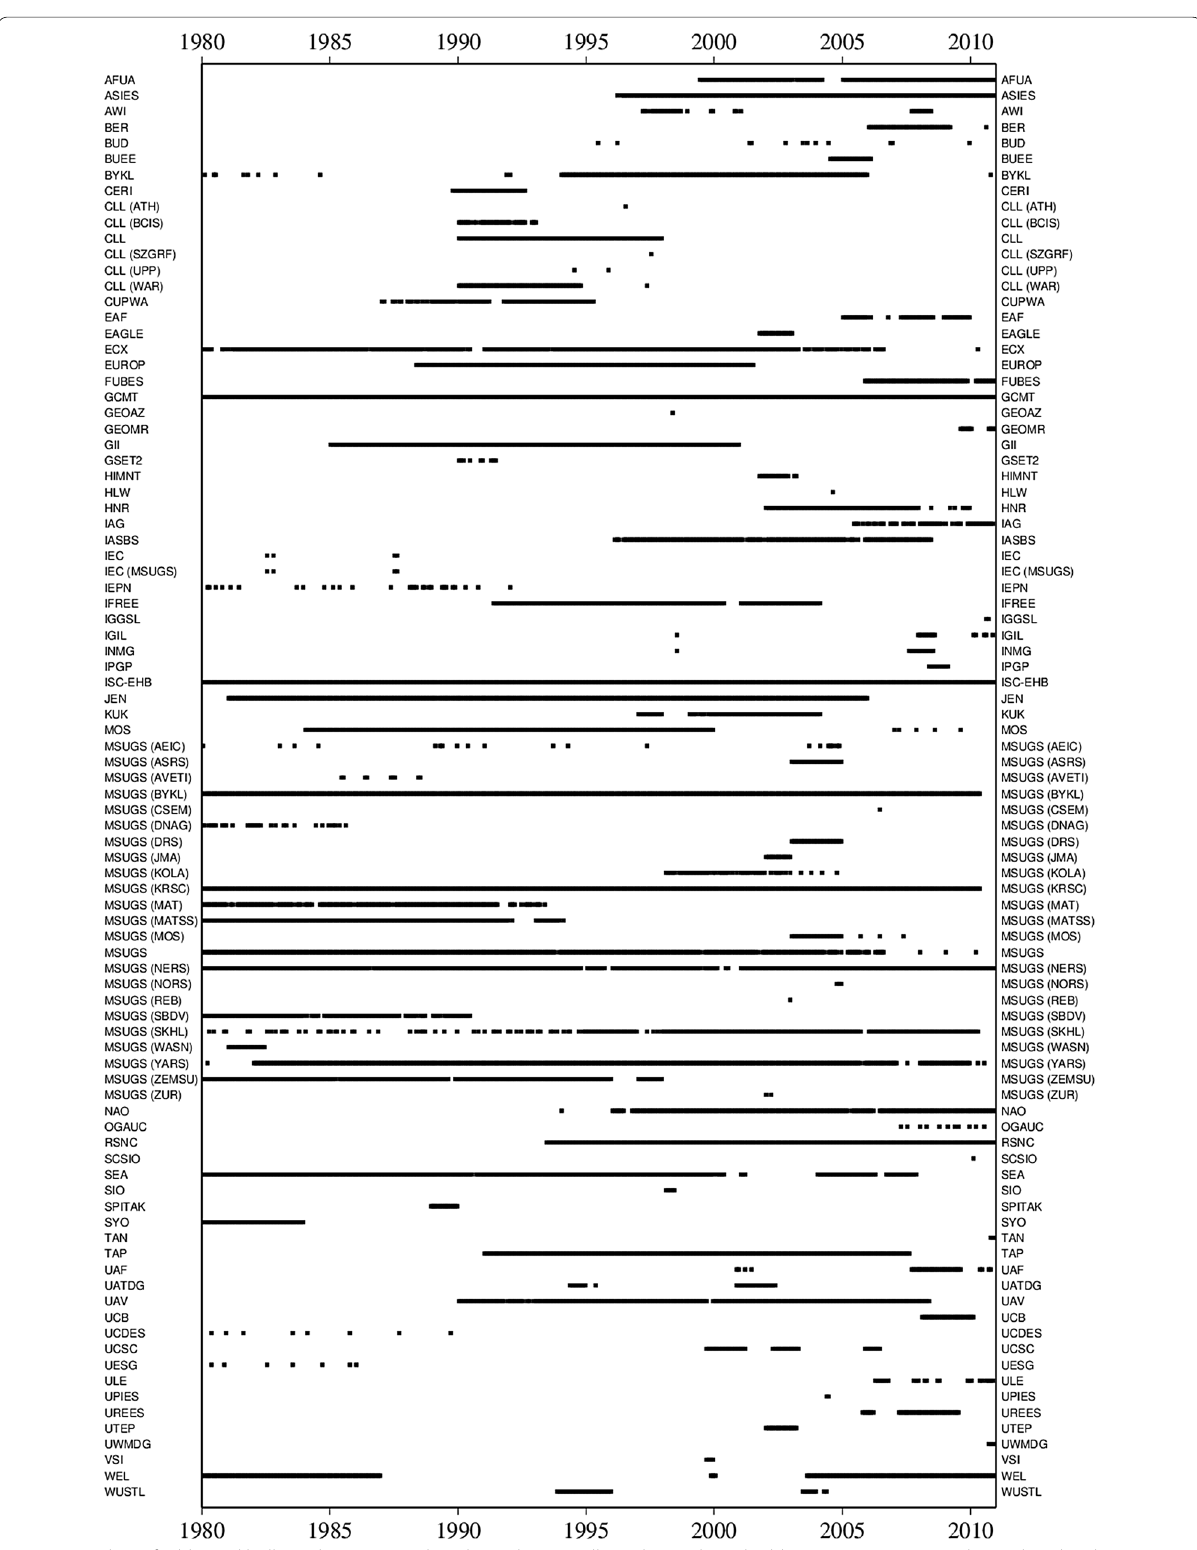
Fig. 2 Timeline of additional bulletin datasets introduced into the ISC Bulletin during the Rebuild project; 90 agency codes are listed in the Appendix; on each line, the first agency code belongs to the reporter of the data and, if different, the second (in brackets)—to its original